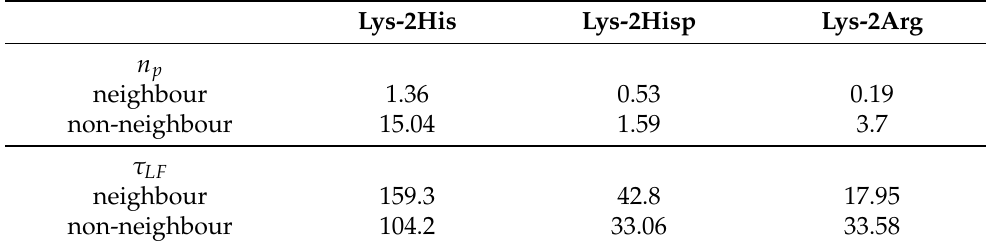
Table 5. The average number n p and the lifetime τ LF (ps) of pairing at T = 310 K for Lys–2His, Lys–2Hisp and